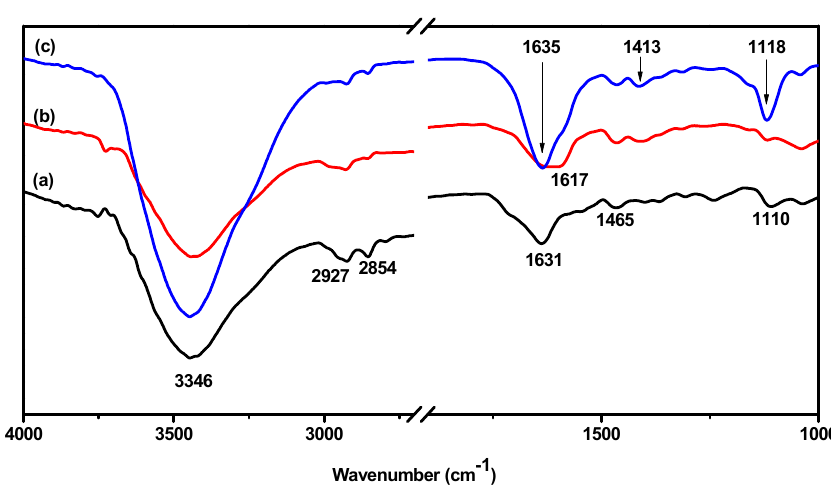
Figure 2. FTIR spectrum of waterborne polyurethane: ( a ) WPU; ( b ) WPU-H; and ( c ) SCPU.